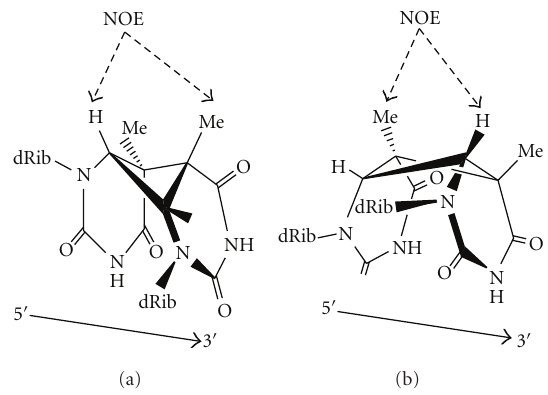
Figure 7: Cis-syn CPD showing the right-handed or left-handed twist in DNA duplex. Dotted arrows elucidate the strongest nuclear overhauser enhancement (NOE) interaction in both cases (Adopted from Lukin and de los Santos